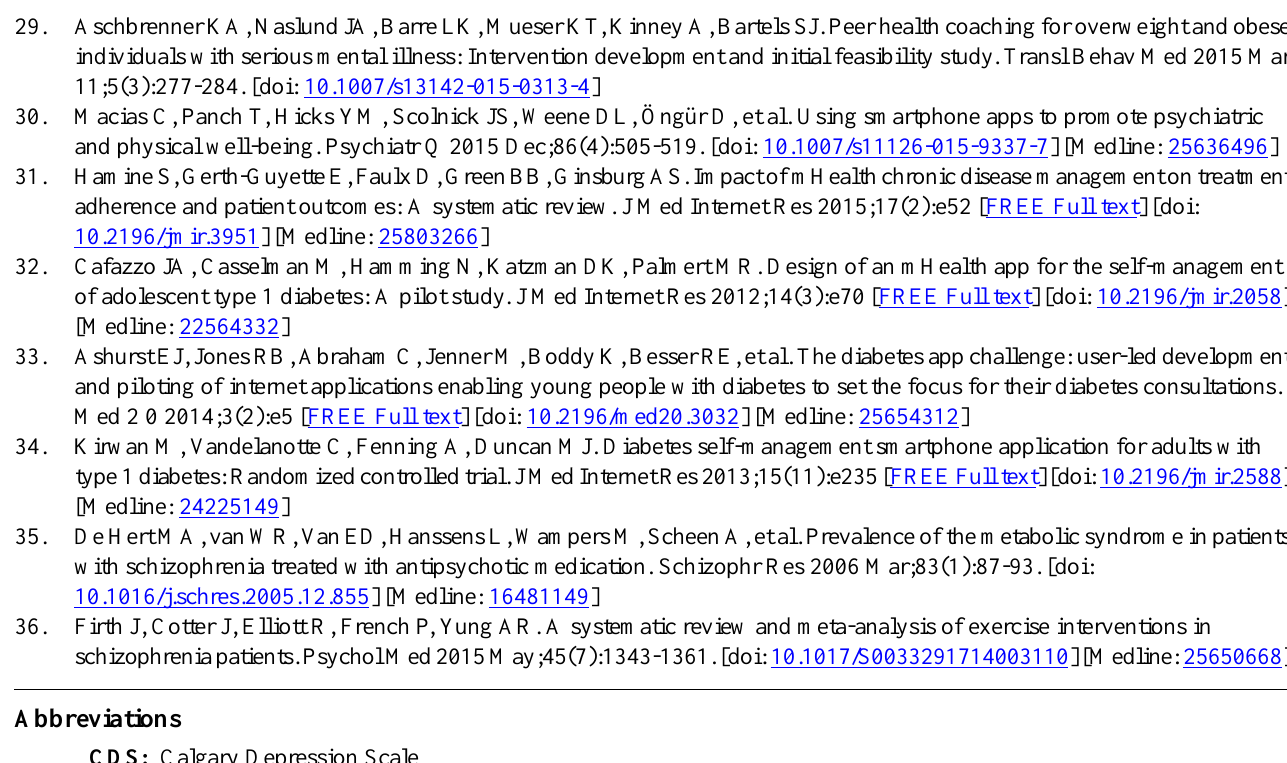
CDS: Calgary Depression Scale PANSS: Positive and Negative Syndrome